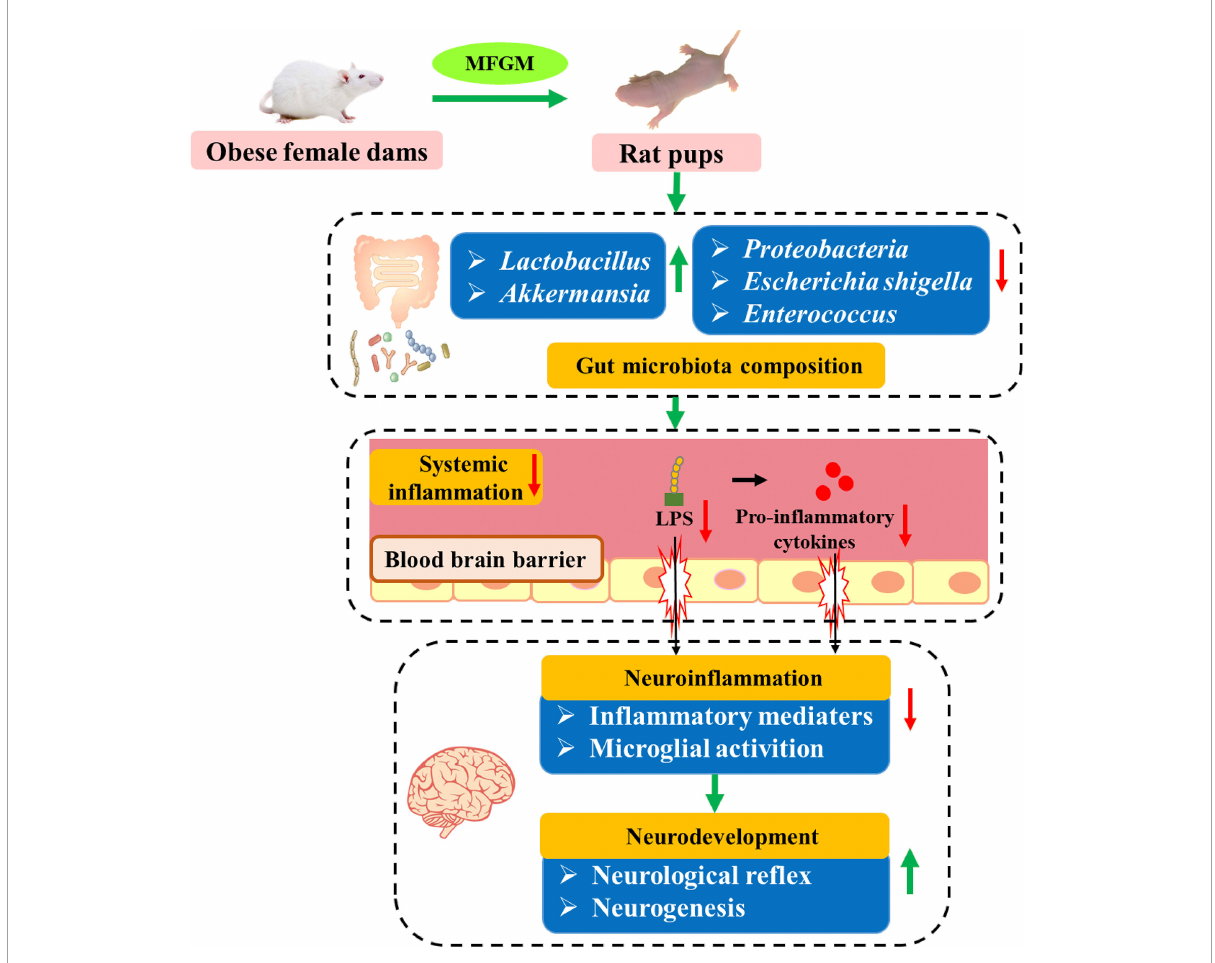
FIGURE7 Possible mechanism for the beneficial effect of maternal MFGM supplementation on the neurodevelopment of